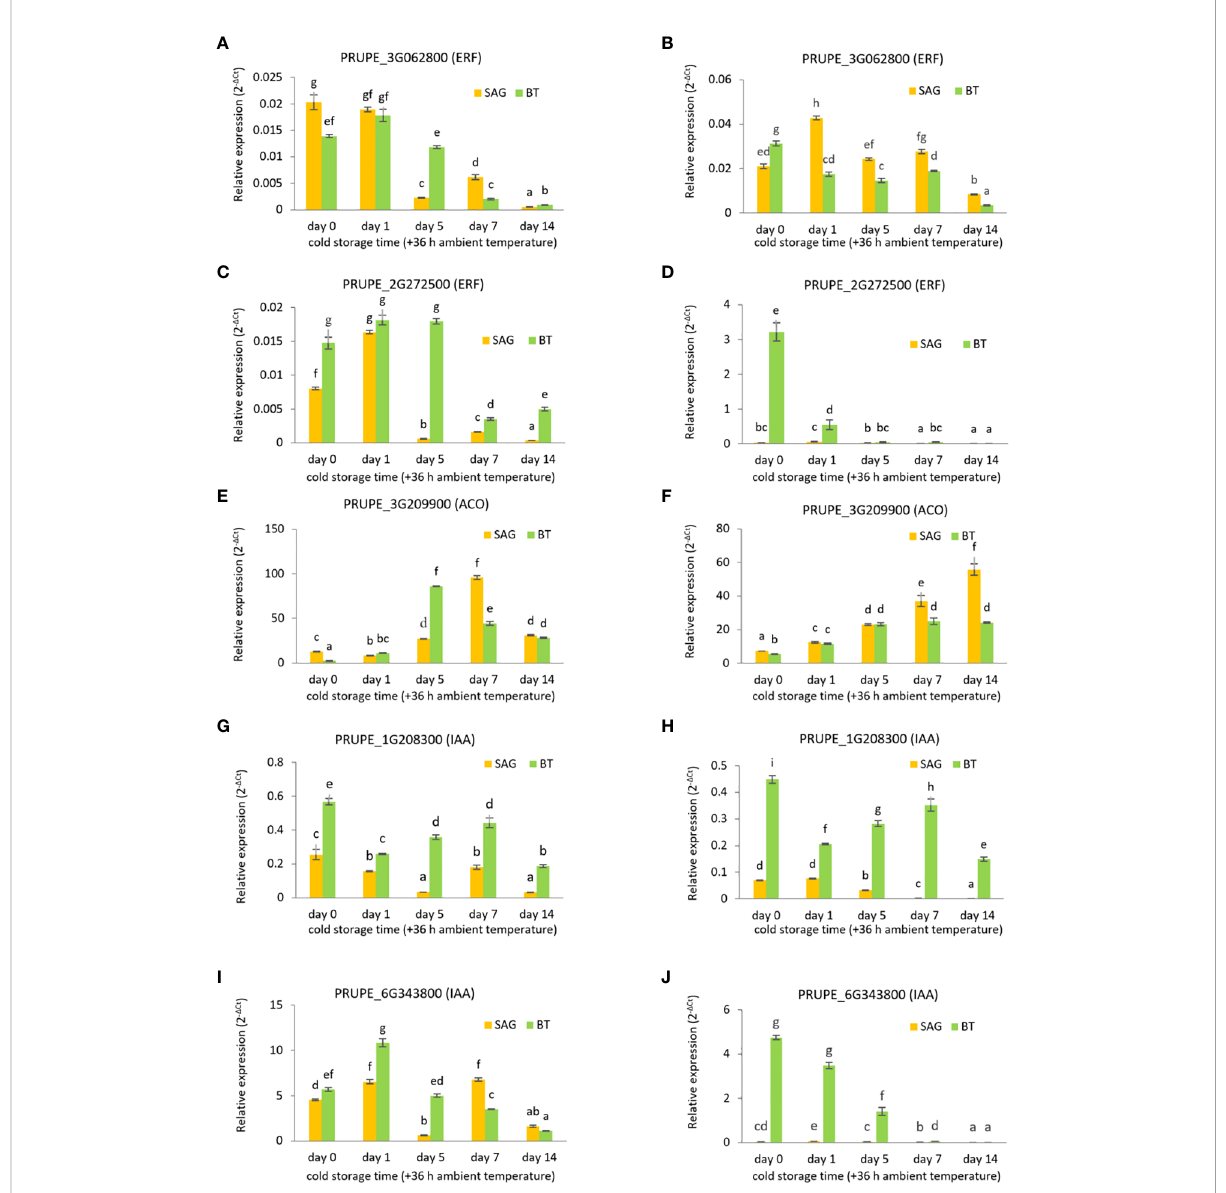
FIGURE 5 Real-time PCR analysis of selected DEGs related to ethylene and auxin signalling in SAG peach and BT nectarine, during cold storage treatment (1°C) at day 0, 1, 5, 7 and 14 followed by 36 h recovery at ambient temperature (22 °C). in two seasons 2017 (A, C, E, G, I) and 2018 (B, D, F, H, J) . PRUPE_3G062800 ( ERF ) (A, B) ; PRUPE_2G272500 ( ERF ) (C, D) ; PRUPE_3G209900 ( ACO ) (E, F) ; PRUPE_1G208300 ( AUX/IAA ) (G, H) ; PRUPE_6G343800 ( AUX/IAA ) (I, J) . Different letters indicate signi fi cant differences among cultivars considering all time points and both years. Statistical analyses were performed using ANOVA and Tukey ’ s ranked test (P < 0.05). Data are the mean ± SE;